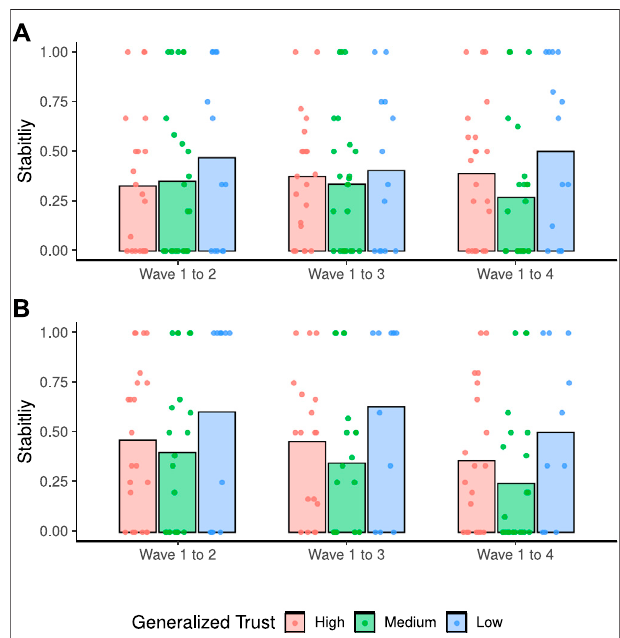
FIGURE 1 | Generalized trust and changes in network compositions across the waves. (A) Advice network. (B) Personal discussion network. In both networks, stability indicates the proportion of ties at Wave 1 remained at the subsequent waves (Waves 2 – 4). Bars represent mean values and scatter plots represent the distributions of observed values. Individuals are classi fi edintothreegroupsaccordingtotheirlevelsofgeneralizedtrustscores (ranging from 6 to 30; M (cid:1) 18.91, SD (cid:1) 4.74). High: individuals high in generalized trust (scores 22 to 30 (larger than M + 0.5 SD ); N (cid:1) 24); Medium: individuals medium in generalized trust (scores 17 to 21 (within M ± 0.5 SD ); N (cid:1) 28);andL:individualslowingeneralizedtrust(scores 6to16(smallerthan M — 0.5 SD ); N (cid:1)